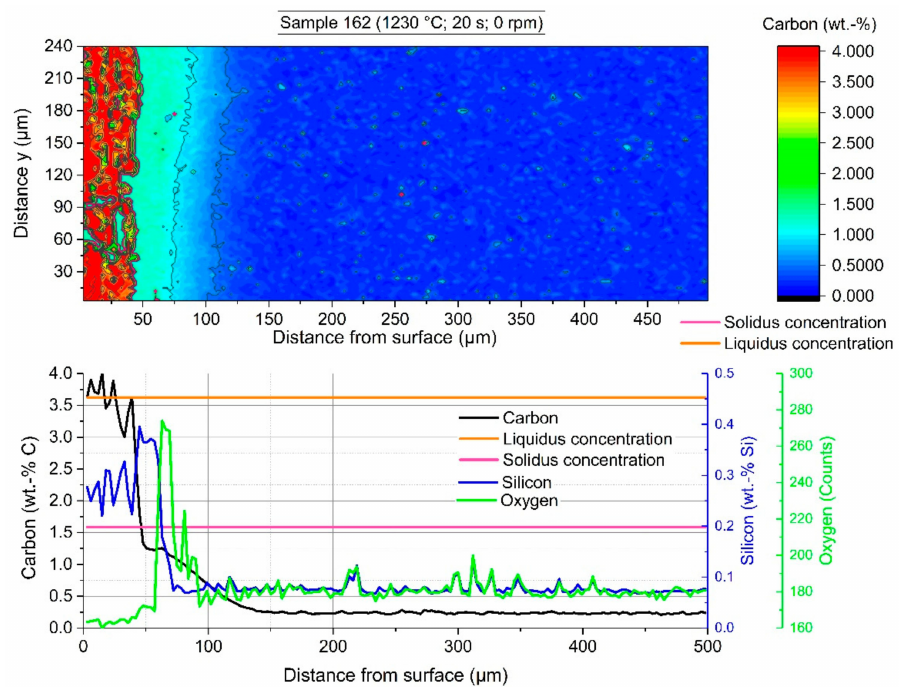
Figure 10. EPMA-measured carbon distribution of sample 162 with an immersion time of 20 s at 1230 ◦ C equilibrium